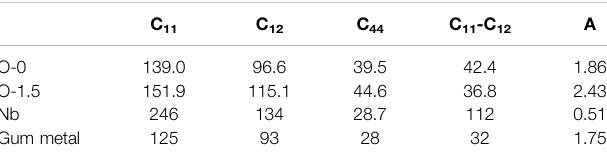
TABLE 1 | Single-crystal elastic constants, (C 11 -C 12 ) values and the anisotropy factor A (cid:1) 2C 44 /(C 11 -C 12 ) of SST O-0 and O-1.5 in comparison with those of Nb and “ Gum Metal